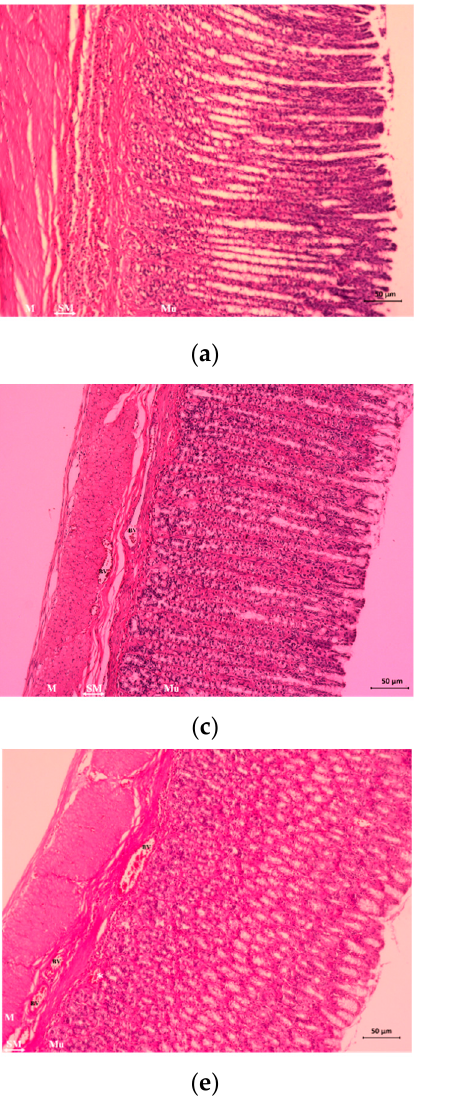
Figure 6. Effects of OMZ and Phy-Blica-D on histopathological lesions in gastric mucosa in rats exposed to ethanol (H&E staining, 400×) ( n = 6 per group). ( a ) Normal group; ( b ) vehicle group; ( c ) OMZ group (20 mg/kg); ( d ) Phy-Blica-D (500 mg/kg) group; ( e ) Phy-Blica-D (1000 mg/kg) group. Abbreviations: Mu = mucosal layer, SM = submucosal layer, M = muscle layer, BV = blood vessel. The white arrows show broad erosion in the upper half of the mucosa, the black arrows indicate inflammatory cell infiltration, and the white asterisk indicates a high degree of hemorrhagic injury. Scale bar = 50 µm.